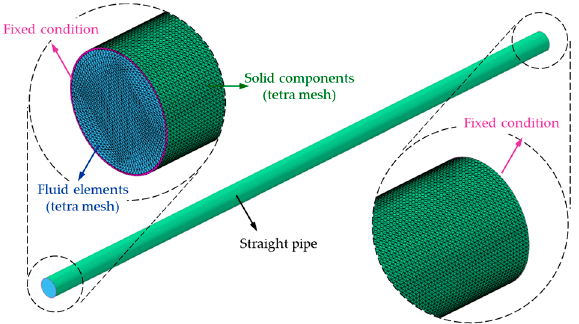
Figure 6. Finite element model for the vibration of clamped-clamped fluid-conveying pipe.